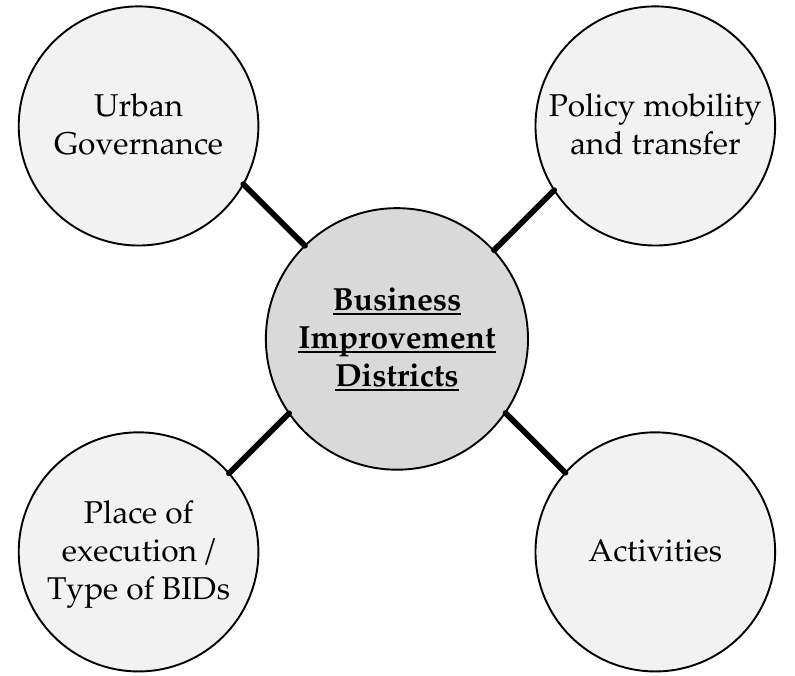
Figure 3. Main research subjects addressed in BID